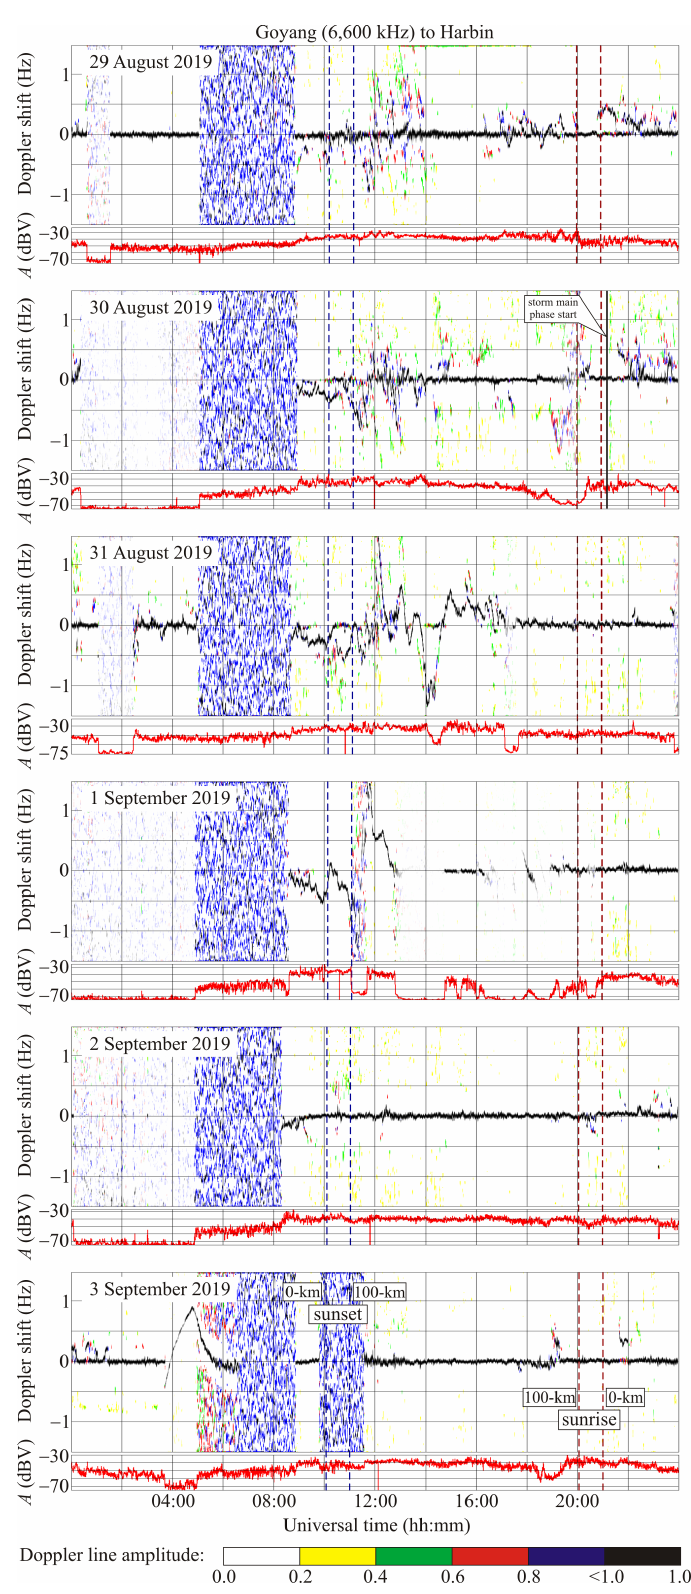
Figure 9. Same as Fig. 5 but for the Goyang to Harbin radio wave propagation path at